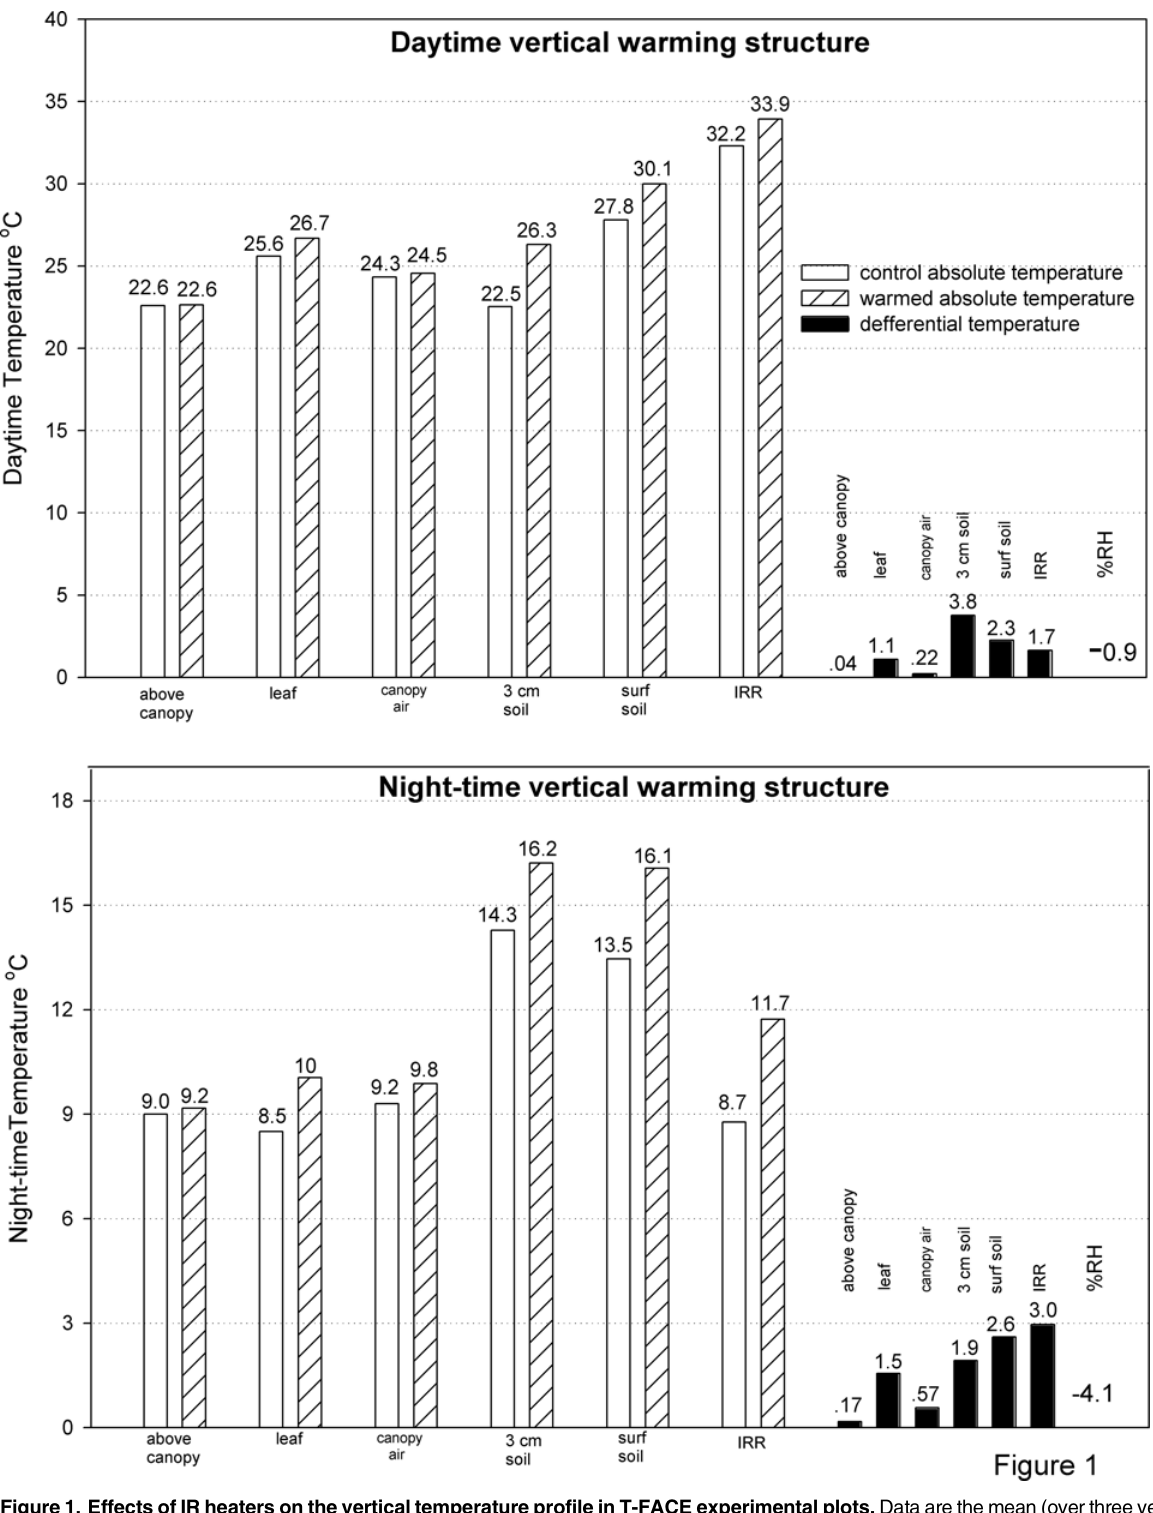
Figure 1. Effects of IR heaters on the vertical temperature profile in T-FACE experimental plots. Data are the mean (over three years) absolute and differential microclimate temperatures and RH of T-FACE infrared heater warmed and control plots during day and night hours (same data used in the analysis of Table 1) at the Prairie Heating and CO 2 Enrichment experiment. IRR is ‘ infrared-radiometer; all other temperatures measured by thermocouples at “ above (the) canopy ” , the underside of “ leaf ” , in the middle of the plant “ canopy-air ” , at “ 3 cm soil ” and “ surface ” soil depths. RH is relative humidity within the plant canopy.